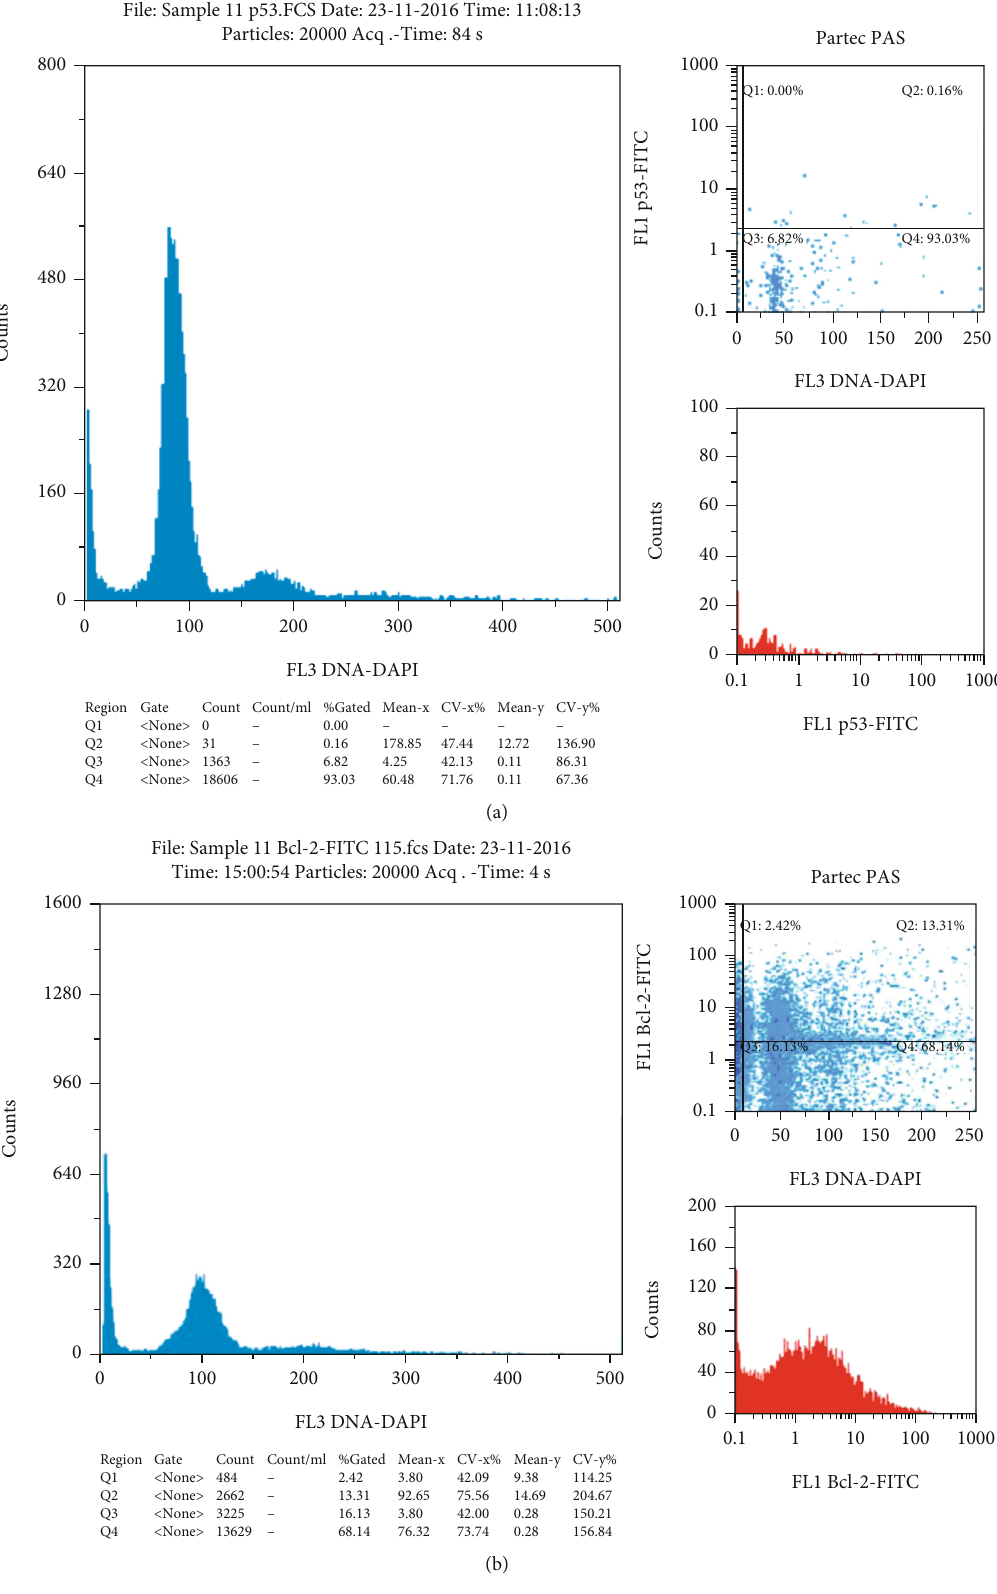
Figure 5: Cytometry result of sample 11: (a) normal chromatin condensation sample with normal p53 activity (0.16% of positively labeled cells); (b) abnormal Bcl-2 activity of the same sample with 13.3% of positively labeled